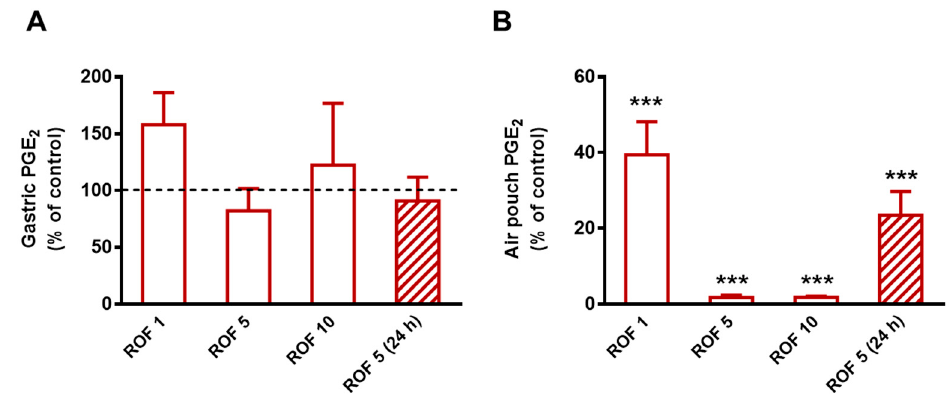
Figure 1. The effect of rofecoxib (ROF, 1 mg/kg, n = 6; 5 mg/kg, n = 8; 10 mg/kg, n = 5) on the levels of PGE2 in the gastric mucosa ( A ) and pouch exudate ( B ) in the carrageenan-airpouch model. The effect of 5 mg/kg rofecoxib was also assayed 24 h after the final gavage (n = 8). The results are expressed as the mean ± SEM percent of the control PGE2 levels measured in vehicle-treated rats. *** p < 0.001 compared to control (one-way ANOVA, Holm-Sidak post hoc test).